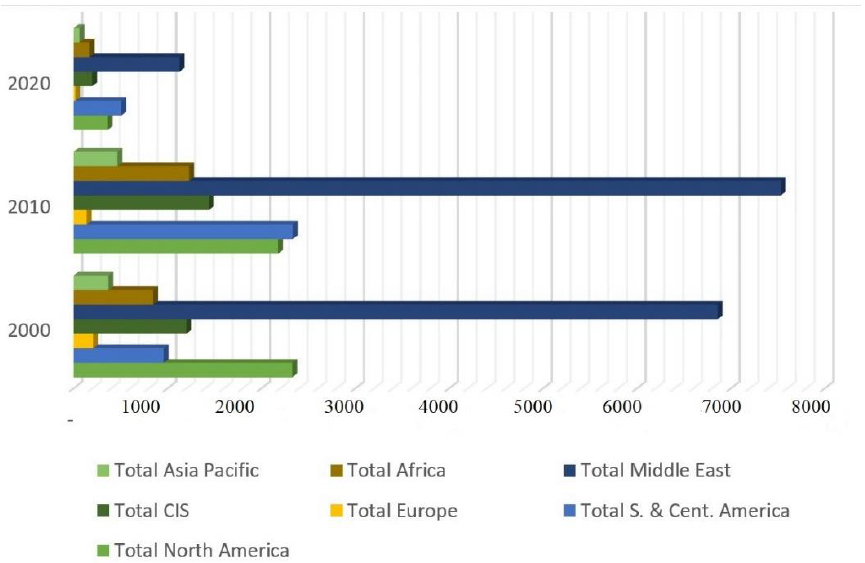
Figure 3. The world’s proved oil reserves (billion tons). Source: developed by the authors based on statistical data